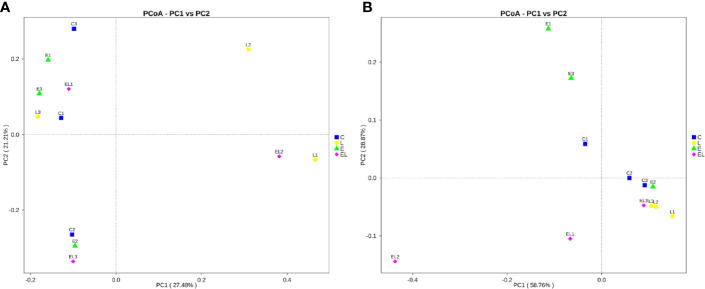
Principal coordinate (PCoA) analysis of gut microbiota in different groups. (A, B) represent PCoA map based on unweighted and weighted uniFrac distance, respectively. Each colored point indicates one sample and the difference in the different groups can be evaluate by the distance between the points.